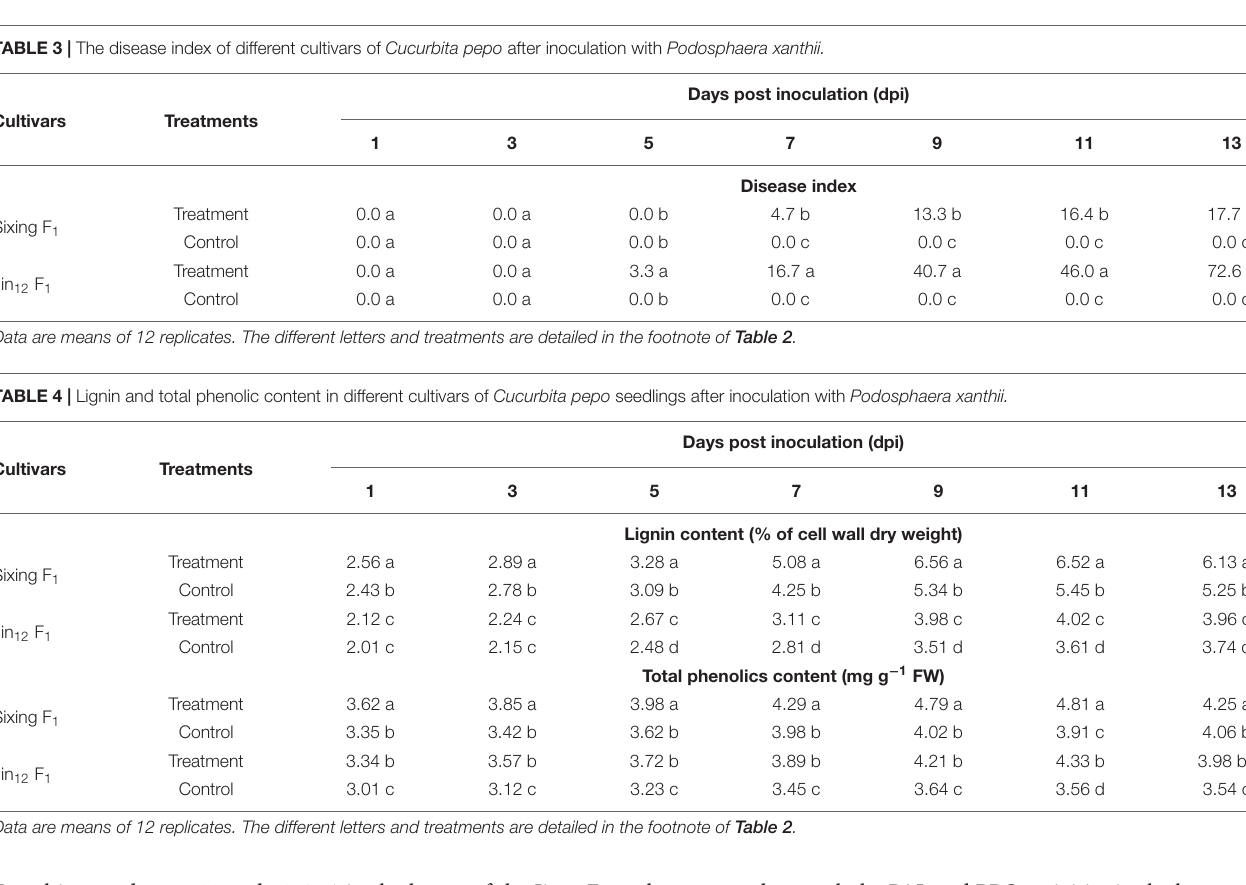
not P. xanthii. TABLE 3 | The disease index of different cultivars of Cucurbita pepo after inoculation with Podosphaera xanthii.